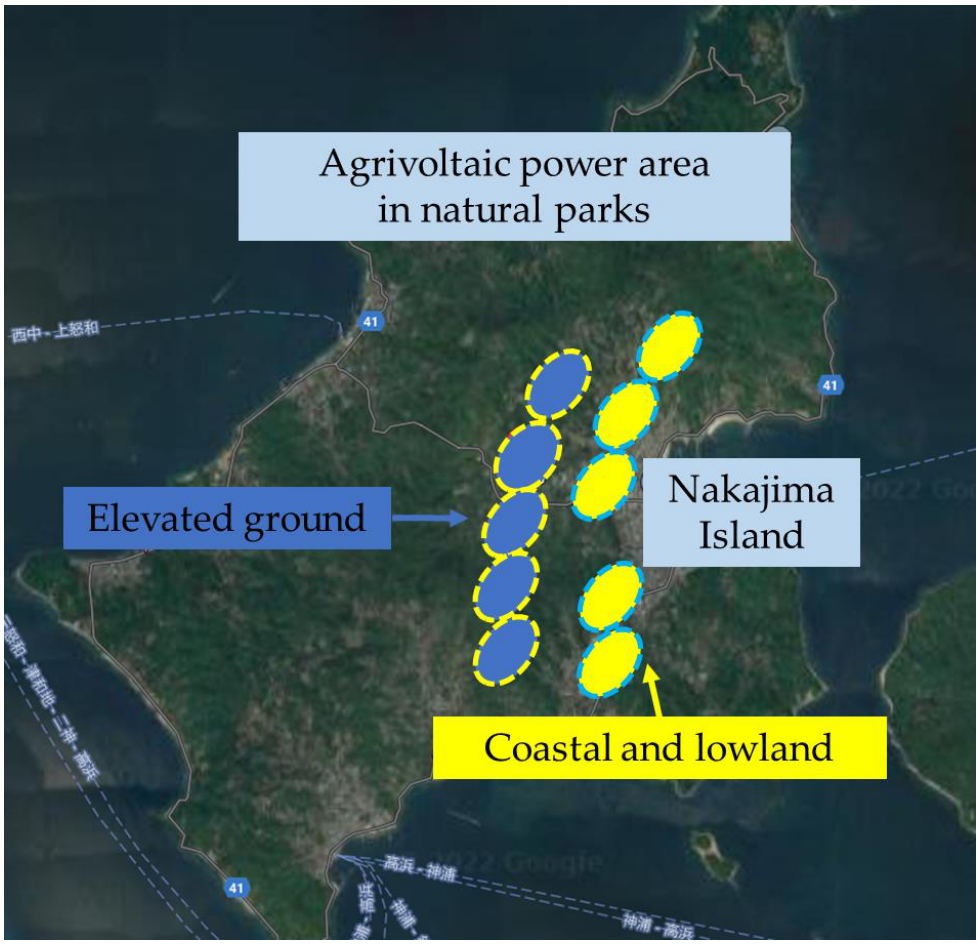
Figure 6. Agrivoltaic power area [coastal and lowland; elevated ground] in natural parks. Diagrams and comments added to the original photograph by the authors.